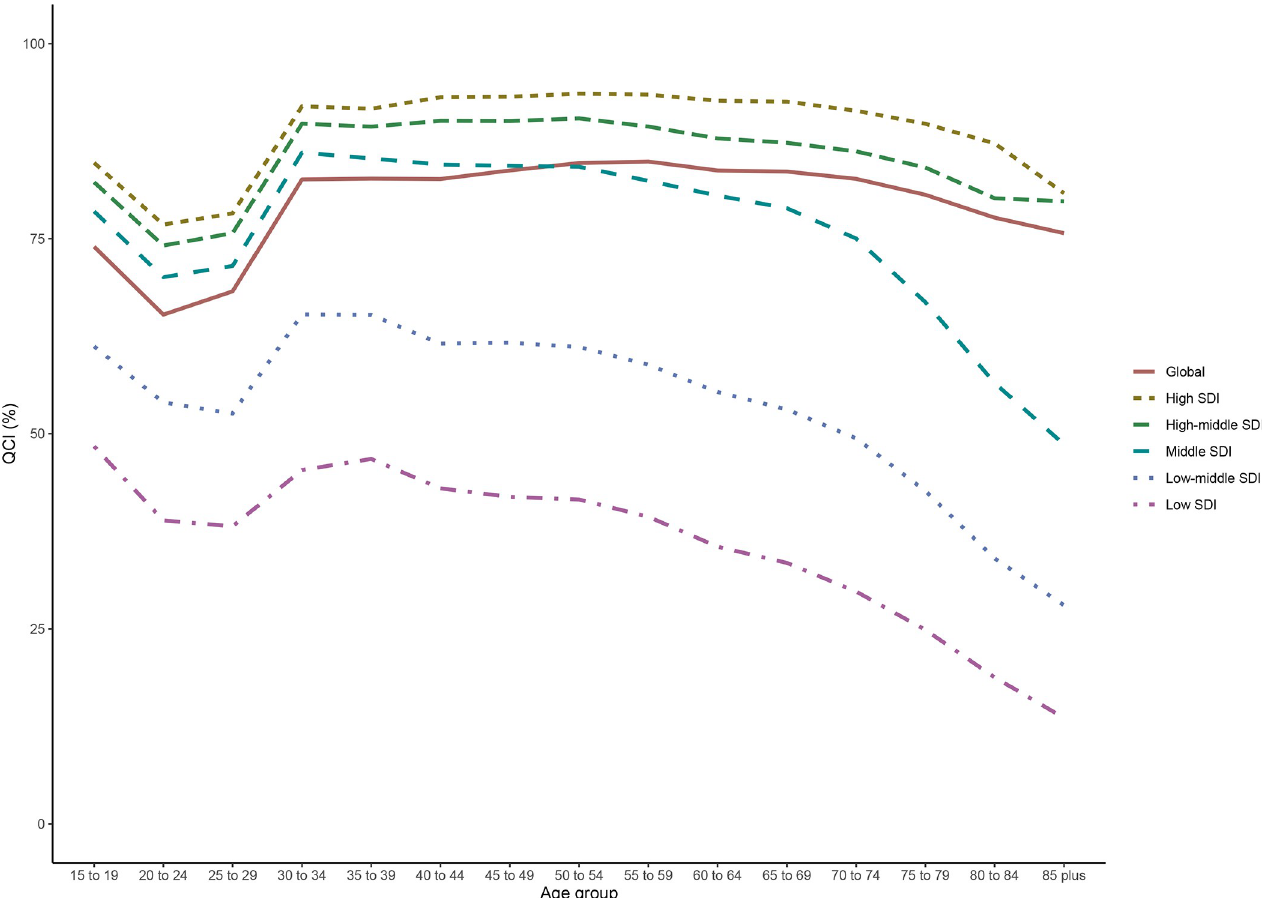
Fig 4. Age trend of QCI (%) in 5-year categories at Global and Socio-demographic index (SDI) quintiles in 2019.